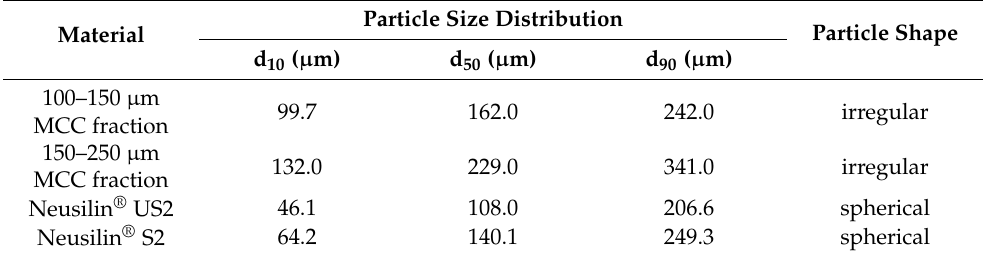
Table 2. Physical characteristics of selected compounds.